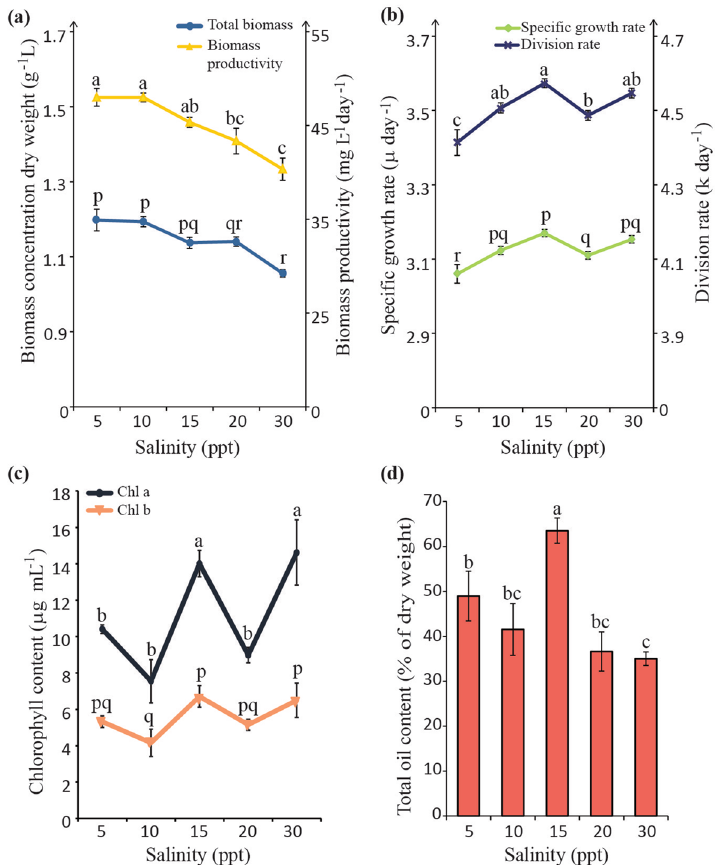
Figure 2. Effect of different salinities on (a) biomass production and biomass productivity; (b) specific growth rate (µ) and division rate ( k ); (c) chlorophyll content and (d) total oil content of C. vulgaris UMT-M1. Data presented are means ± SD of three biological replicates. Different series of letters represent significant differences within each parameter measured (Fisher’s LSD (SPSS software), p <